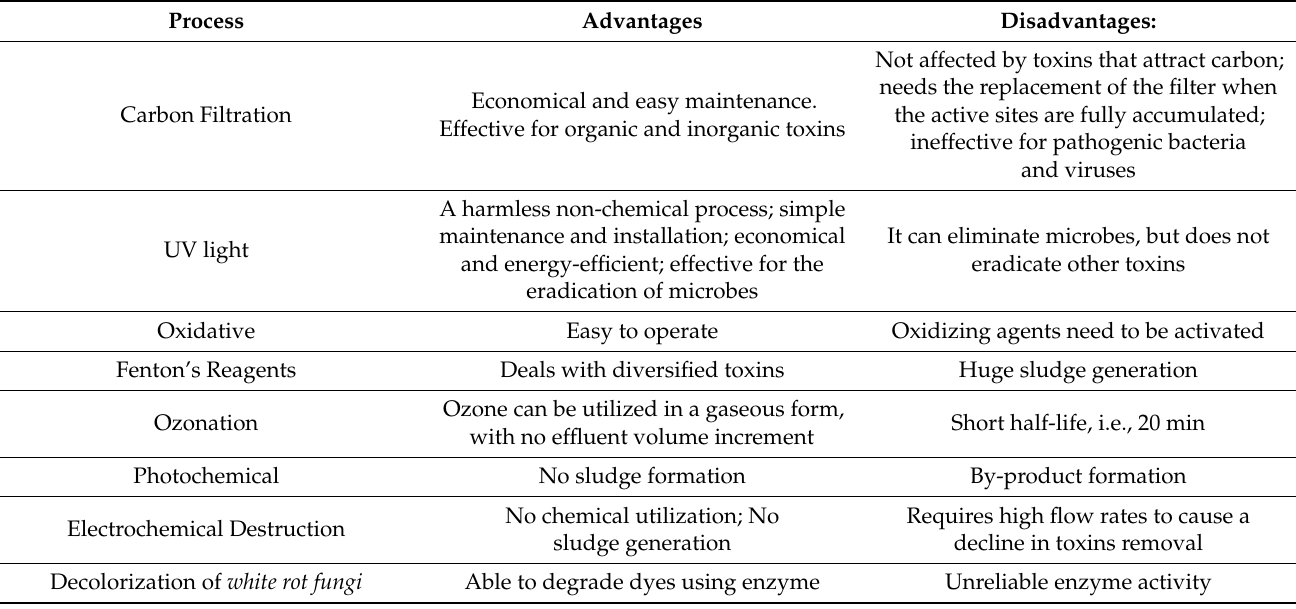
Table 8. Comparison of Conventional to Green Processes for toxins eradication.